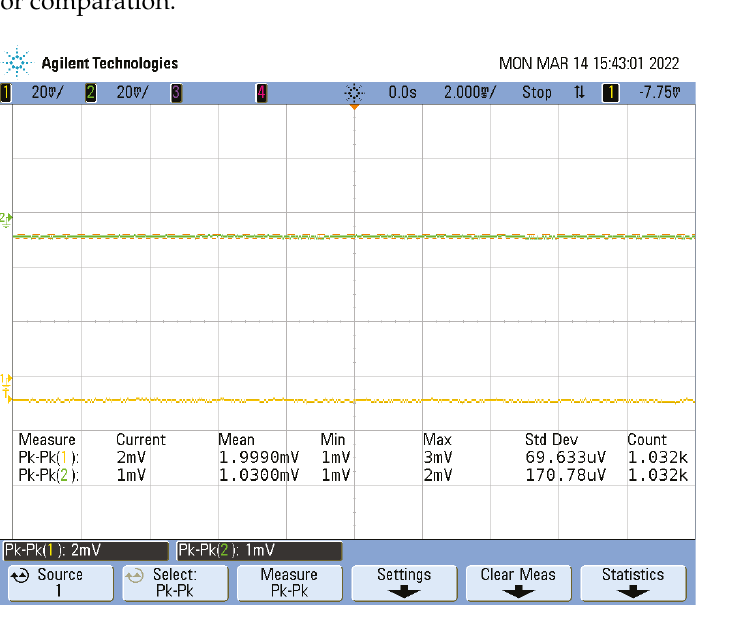
Figure 7. Noise at the output of the experimental device (with 1 M (cid:461) resistor at the test terminals). Channel 1 (yellow): actual output of the device. Channel 2 (green): shorted probe (for comparison purposes).